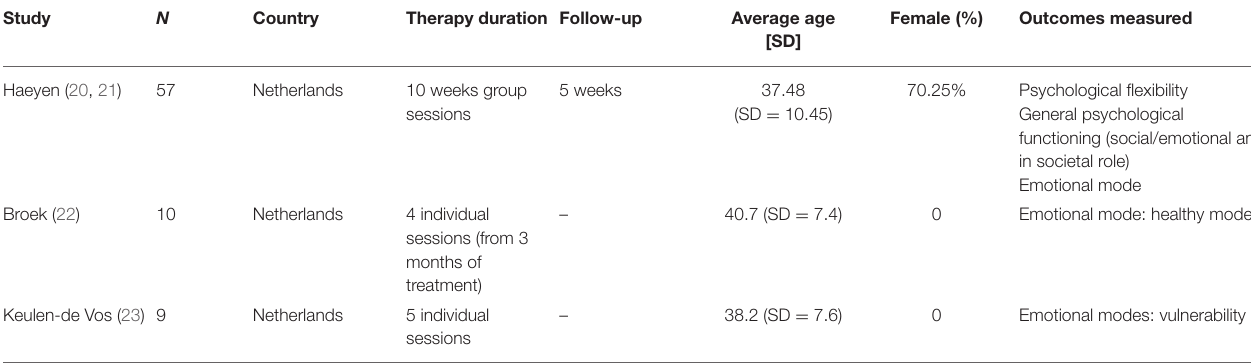
TABLE 4 | Characteristics of the studies included. Study N Country Therapy duration Follow-up Average age